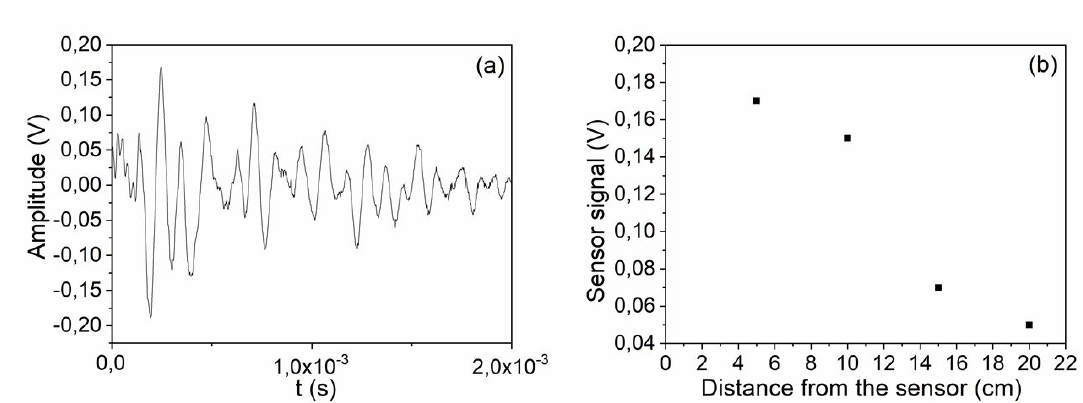
Figure 10. Sensor response to a pencil-lead break as a function of the time for sample with 34 vol.% (90 rods) of